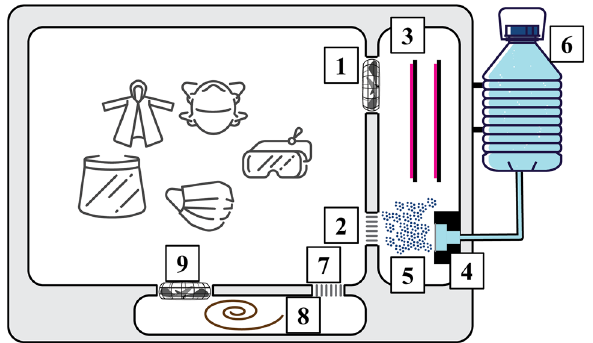
Figure 1. Schematic of plasma system. It consists of three chambers: large 53-L open area for the PPE, the plasma chamber (#1–6) and heating chamber (#7–9): 1. Fan forcing the air into the plasma chamber. 2. Exit from the plasma chamber where droplets, mixed with plasma-generated reactive oxygen and nitrogen species (RONS) are introduced into the area with the PPE. 3. Plasma is generated with a 20 kHz, 3,000 V dielectric barrier discharge. 4. Ultrasonic nebulizer is used to generate water microdroplets with mean diameter of ~ 5 µm. 5. Water microdroplets form a dense fog that is produced immediately after the plasma zone and mixed with RONS. 6. Each cycle consumes 1 ml of DI water or other solutions and our current prototype has a 750 ml container. 7. For the heated air cycle, the air (containing residual RONS and moisture) is sucked in from the chamber with the PPE. 8. The air-RONS-moisture is heated to 50 °C to facilitate removal of the residual reactive chemistry and drying of the PPE. 9. Warm air is forced into the chamber with the PPE by a